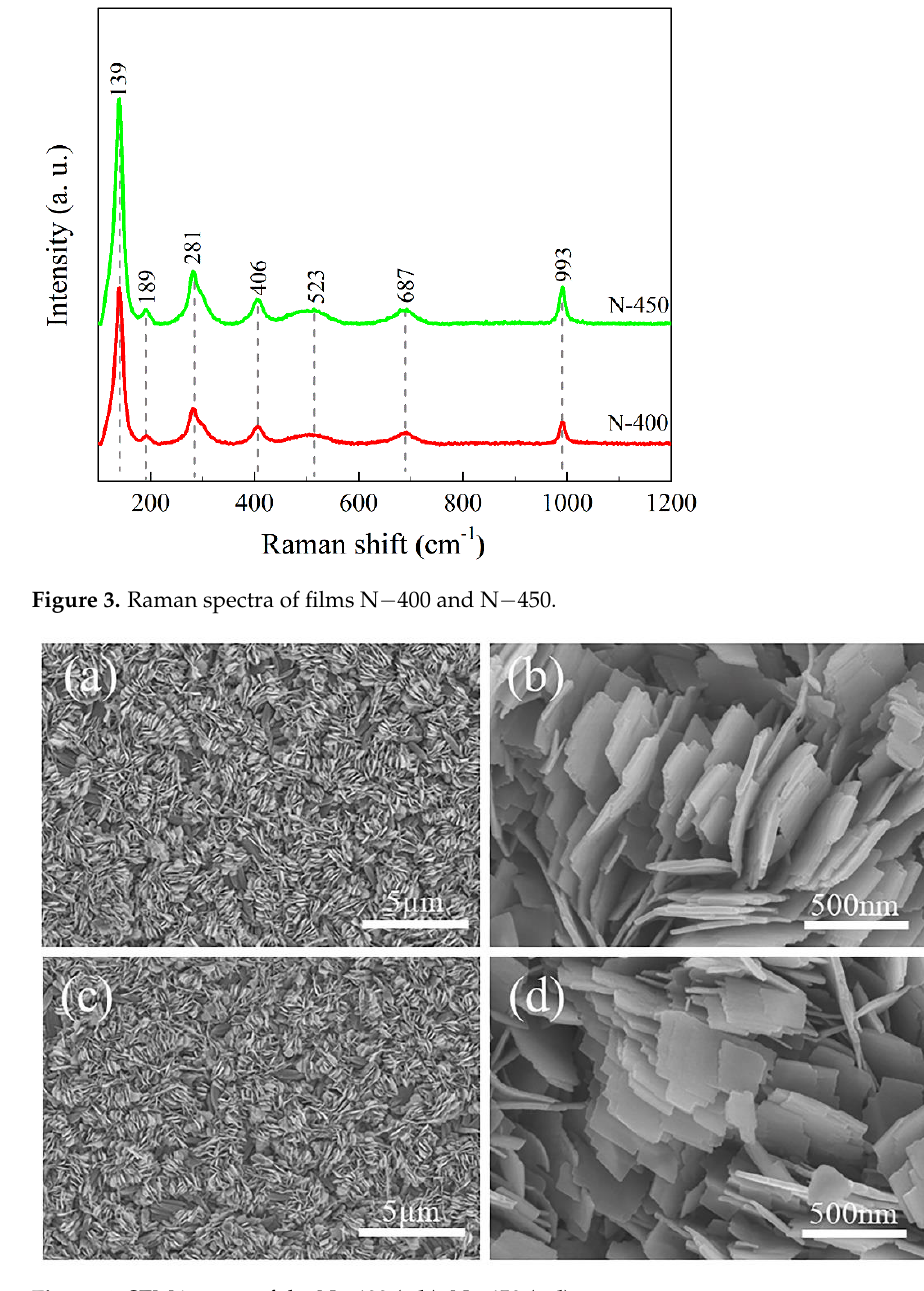
Figure 4. SEM images of the N − 400 ( a , b ); N − 450 ( c , d ).